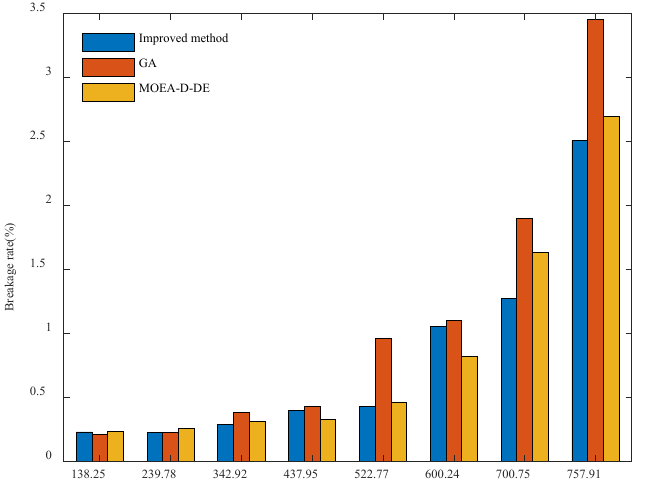
Figure 10. Comparison of the breakage rates.